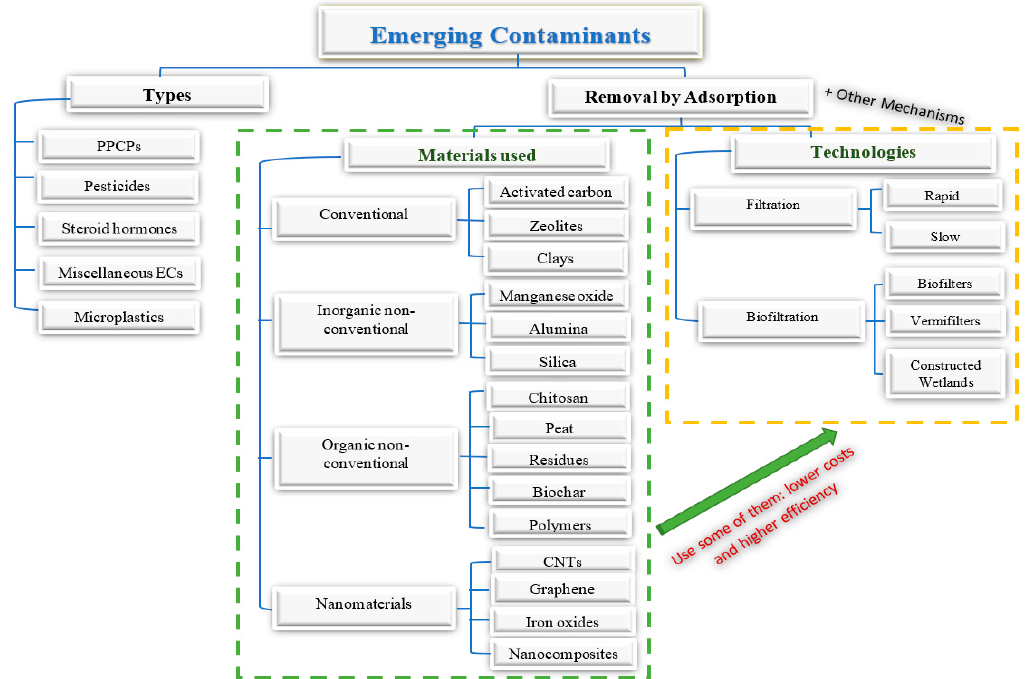
Figure 2. Topics featured in this review.